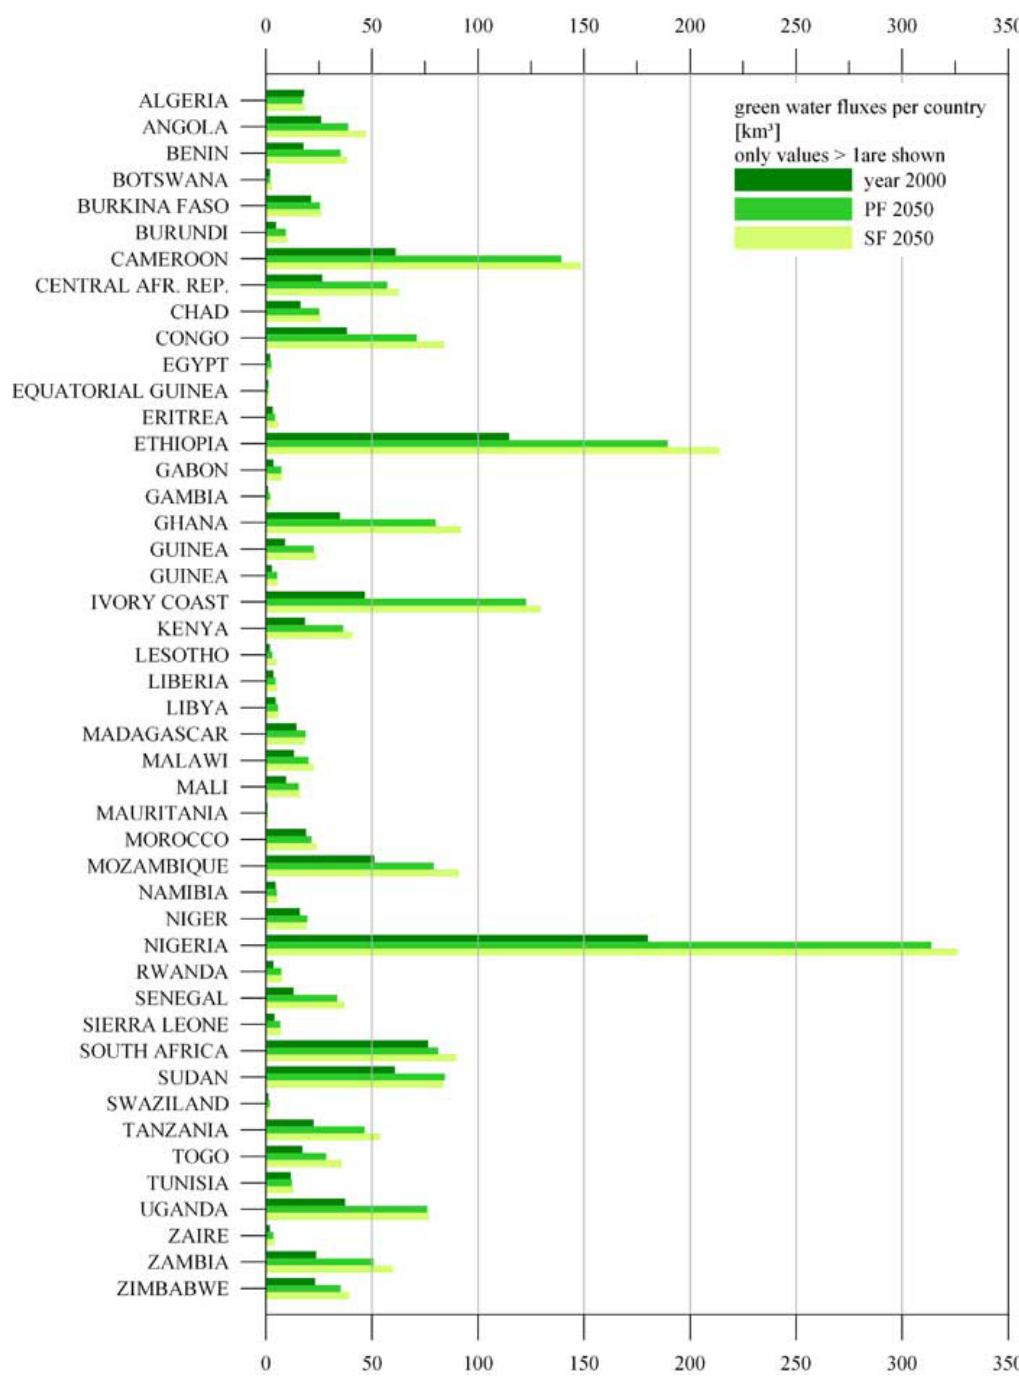
Figure 6. Country-level green water fluxes from cropland for the year 2000, and for the “Policy First” and “Security First” scenarios for